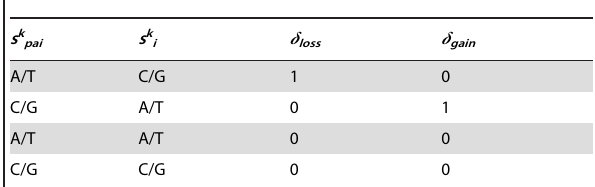
Table 1. A/T gain and loss delta